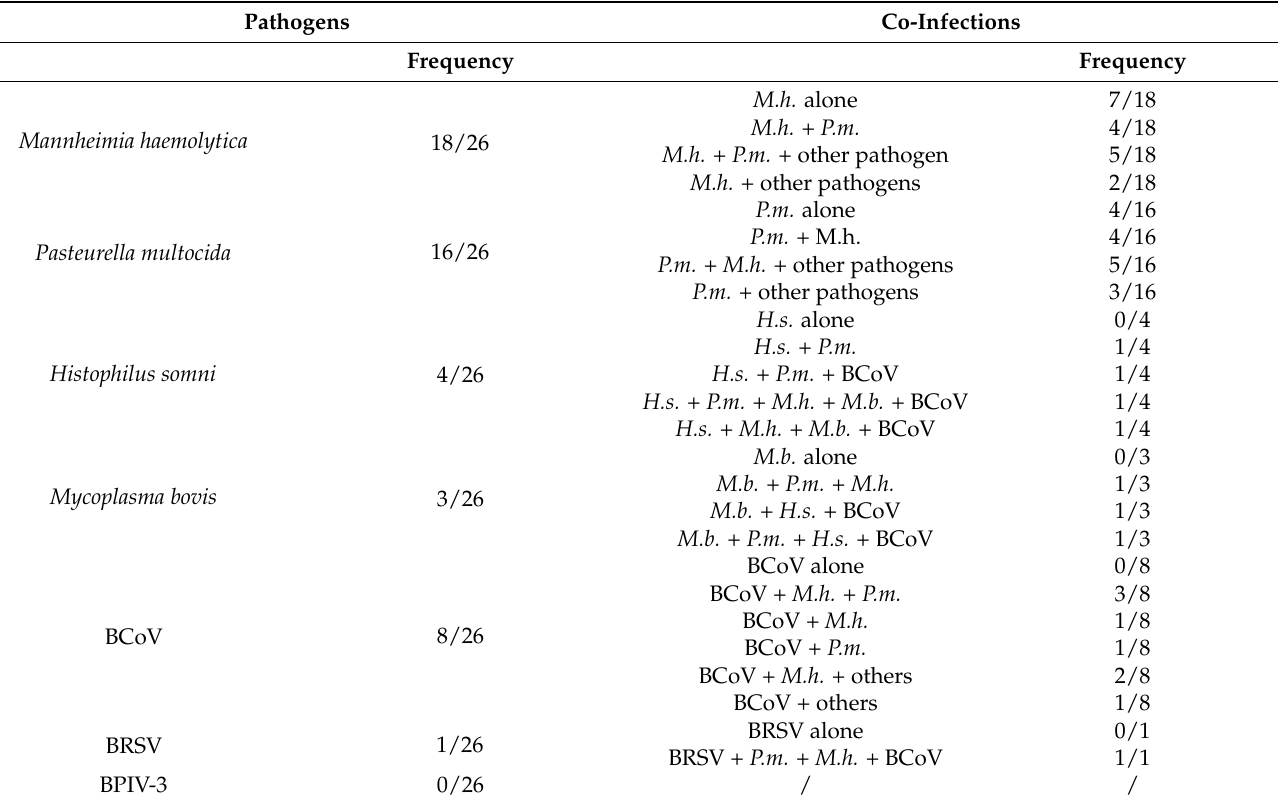
Table 4. Frequency of co-infections between pathogens ( n =